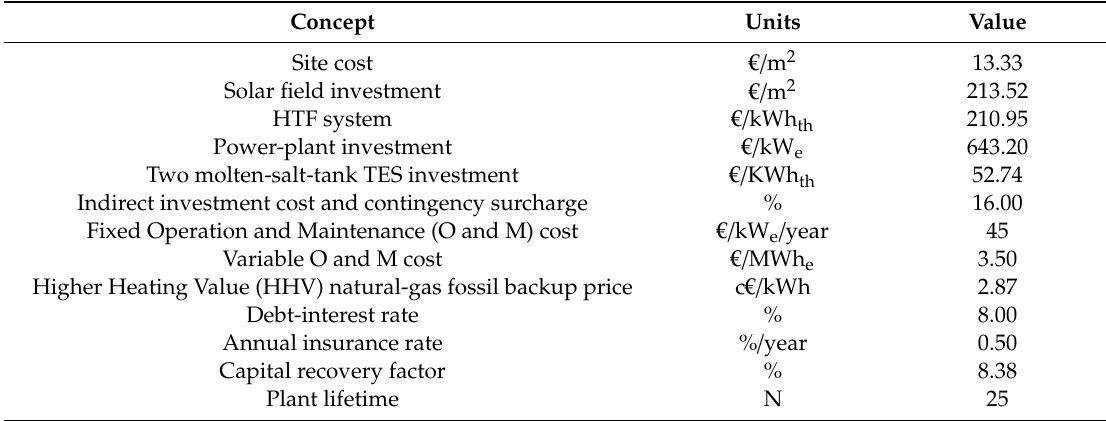
Table 7. Main data for PT power plant—levelized cost of electricity (LCOE) calculation